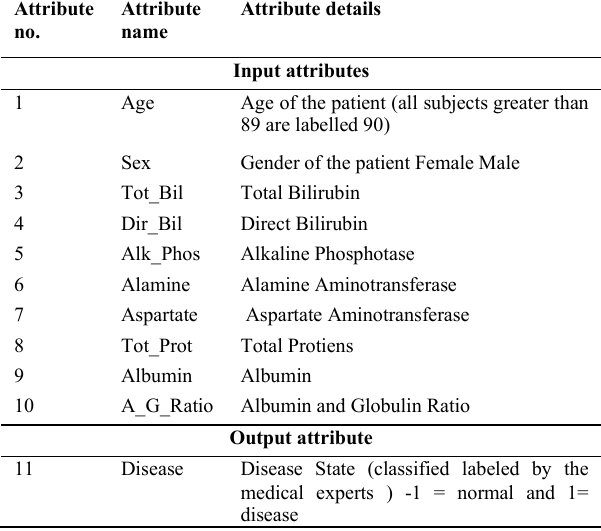
Table 1. Attribute details of